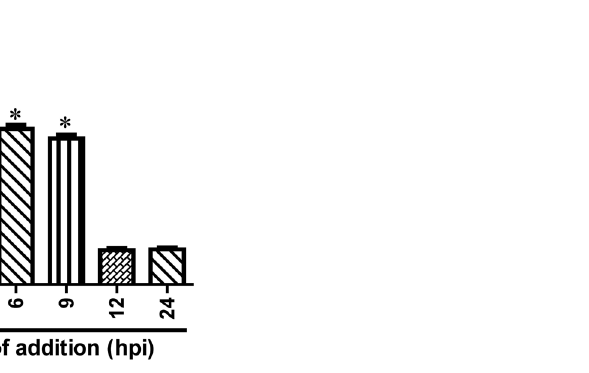
Fig 3. Luteoloside inhibited EV71 production in a time-dependent manner. RD cells were infected EV71 (MOI = 0.3). 0.5 mM luteoloside were added at the indicated time points, respectively. Uninfected cells were used as a control group. The cell viability was detected using MTS cell proliferation assay kit at 48 hpi. The viability of control group was set as 100%. Data shown are the means ± SE from 6 independent measurements ( n = 6), asterisk means P < 0.05 according to t -test comparing with EV71